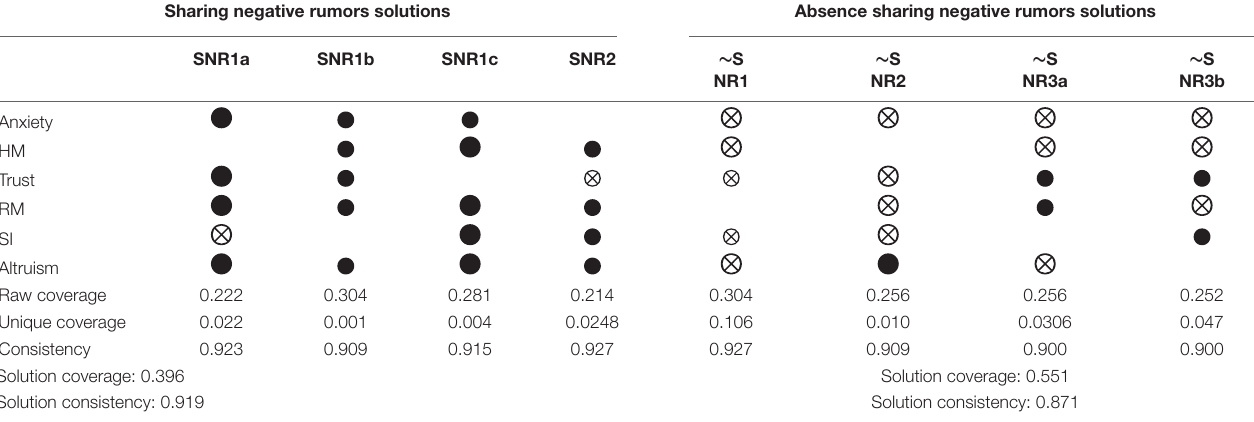
TABLE 5 | Configurations for sharing and absence sharing negative